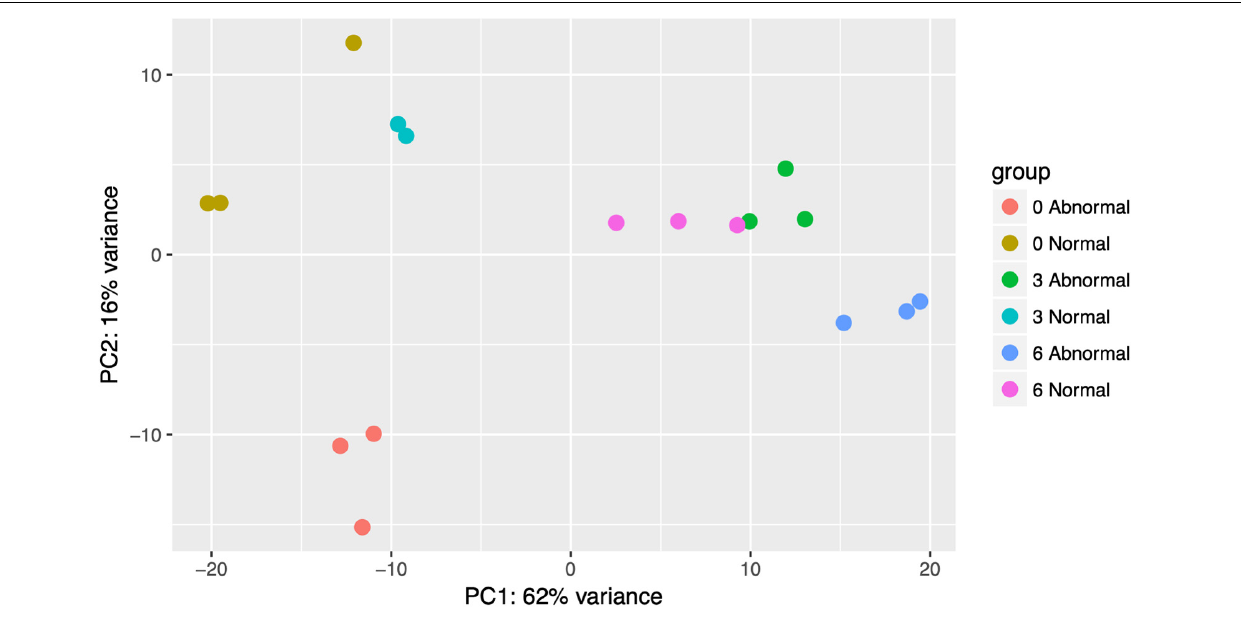
1,805 at 6 µ g/l. There were 163 shared markers of effect at both copper concentrations, but 1,267 markers of effect were unique to 3 µ g/l, and 1,370 markers were unique to 6 µ